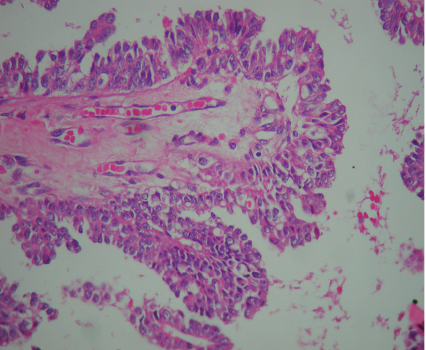
Figure 3: Higher magnification of one of the papillary structures (H. E. × 400).